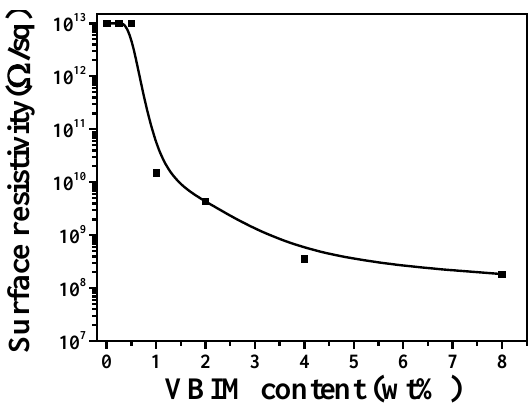
Figure 8. Surface resistivity of PA6 and the PA6/VBIM blends as a function of VBIM contents. This section may be divided by subheadings. It should provide a concise and precise description of the experimental results, their interpretation, as well as the experimental conclusions that can be drawn.